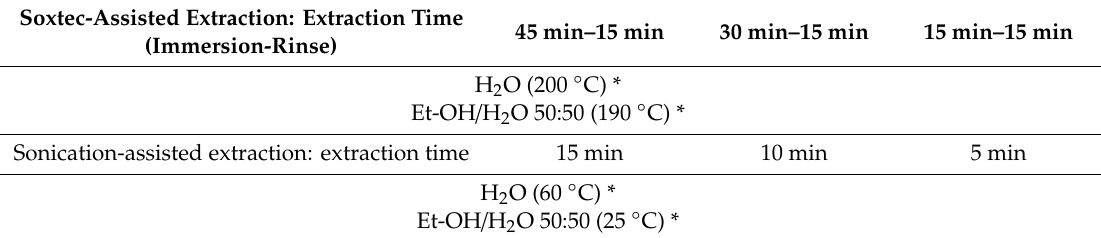
Table 1. Extraction